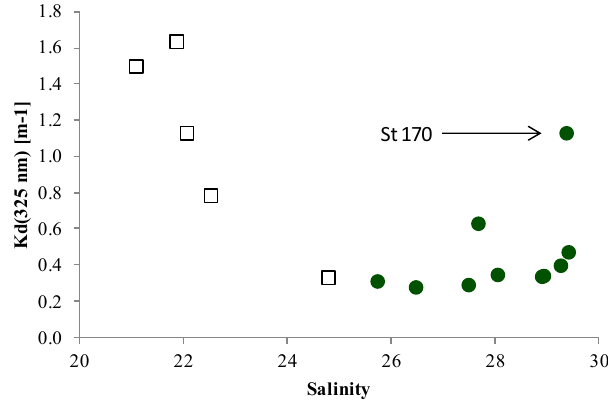
Fig. 3. Diffuse attenuation coefficient of light for K d at 325nm as a function of surface salinity in the North East (circles) and Figure 3. Diffuse attenuation coefficient of light for K d at 325 nm as a function of surface 735 North West (squares) sectors. Station 170 was characterized by high DOC (115 µM), chlorophyll a (1.72µgL − 1 ) , primary productivity salinity in the North East (circles) and North West (squares) sectors. Station 170 was 736 (37.9mgCm − 3 d − 1 ) and a CDOM (350) (0.56m − 1 ) content. A sim- ilar pattern was observed for 340 and 380nm wavelengths and for characterized by hig h DOC (11 5 µ M), Chlorophyll a (1.72 µ g l - 1 ), primary productivity (37.9 737 PAR spectral domain. mgC m - 3 d - 1 ) and a CDOM (350) (0.56 m - 1 ) content. Similar pattern was observed for 340 and 738 380 nm wavelengths and for PAR spectral domain. 739